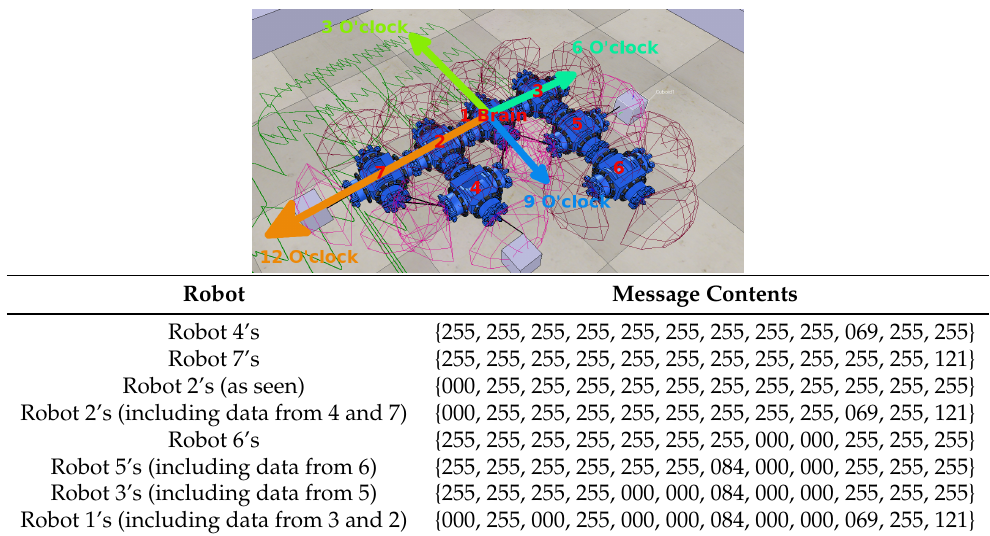
Figure 5. A visualisation of clock hand data flows. Temporary ID numbers are marked in red. Data structures start at 1 o’clock direction and run to 12 o’clock. Here, 255 implies no known data in this direction, 0 implies no objects in range, numbers from 1 to 254 show objects at decreasing ranges. Note how, to avoid false positive detections, Robots 4 and 7 ignore the detections of each other in their own data